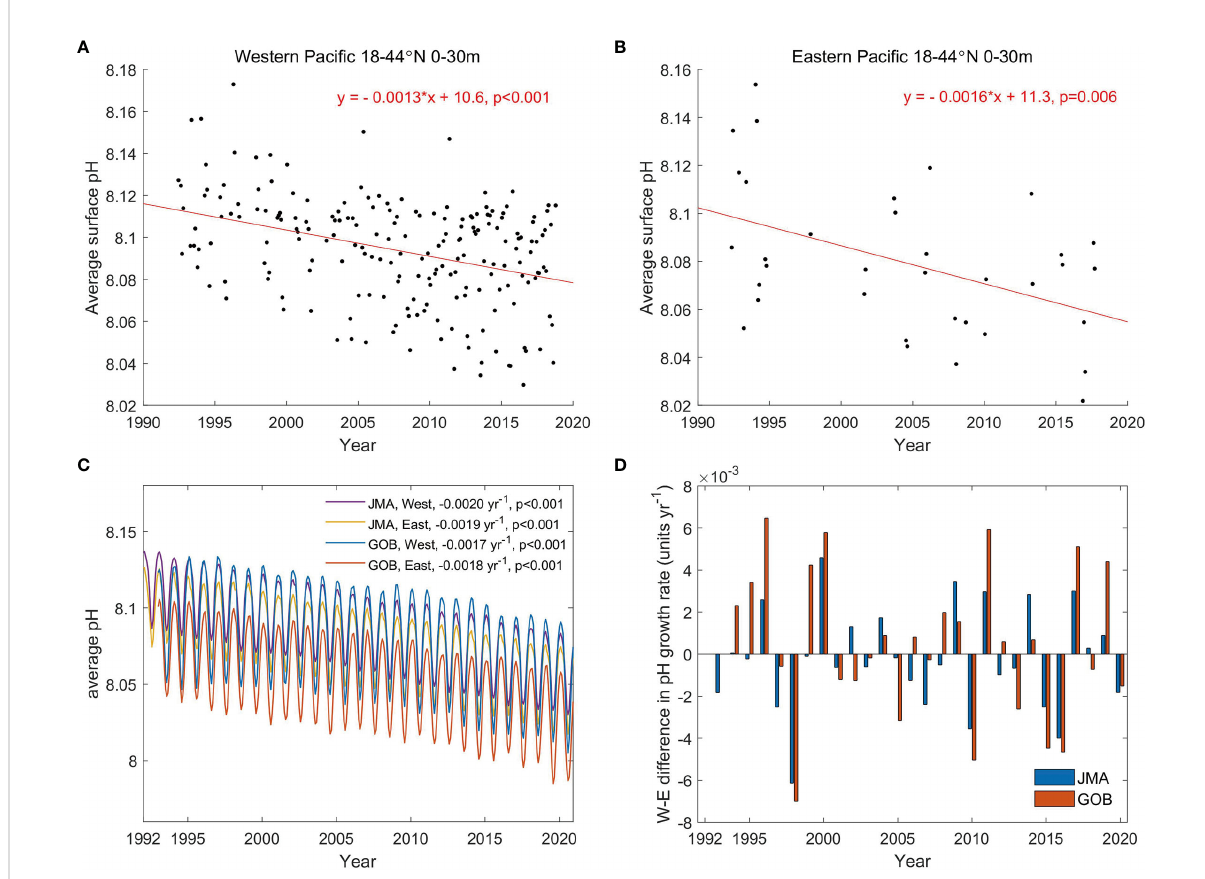
FIGURE 5 Average pH in the northern temperate Paci fi c (18-44° N) from GLODAP and gridded pH product during 1992-2020. (A) : average pH in the western Paci fi c 18-44° N at 0-30m; (B) : average pH in the eastern Paci fi c 18-44° N at 0-30m; (C) : average surface ocean pH in the western and eastern temperate Paci fi c 18-44° N from the Japan Meteorological Agency (JMA) product and the Global ocean biogeochemistry hindcast product (Perruche, 2018; Iida et al., 2021); (D) : west-east difference in the average pH growth rate of different pH products (trend west -trend east ), the positive values suggest that the pH in the eastern Paci fi c decreases faster. The symbol “ * ” represents a multiplication